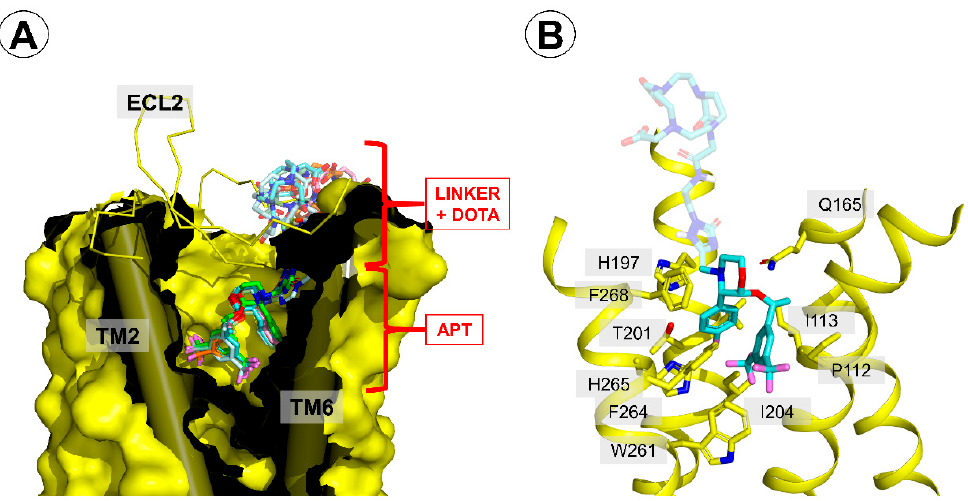
Figure 5. Binding mode of the reported conjugates in the neurokinin 1 receptor (NK1R) binding site. ( A ) A generalized view on the binding mode. The receptor is displayed as a yellow surface, with transmembrane helices (TMs) 2 and 6 shown as cylinders. The extracellular loop 2 (ECL2) is shown as a yellow ribbon. The conjugates are represented as colored sticks. ( B ) A view focused on the interactions of the part common to aprepitant and the conjugates. The conjugate shown is compound 5A (pale blue sticks). Only several residues of the receptor are shown (yellow sticks).